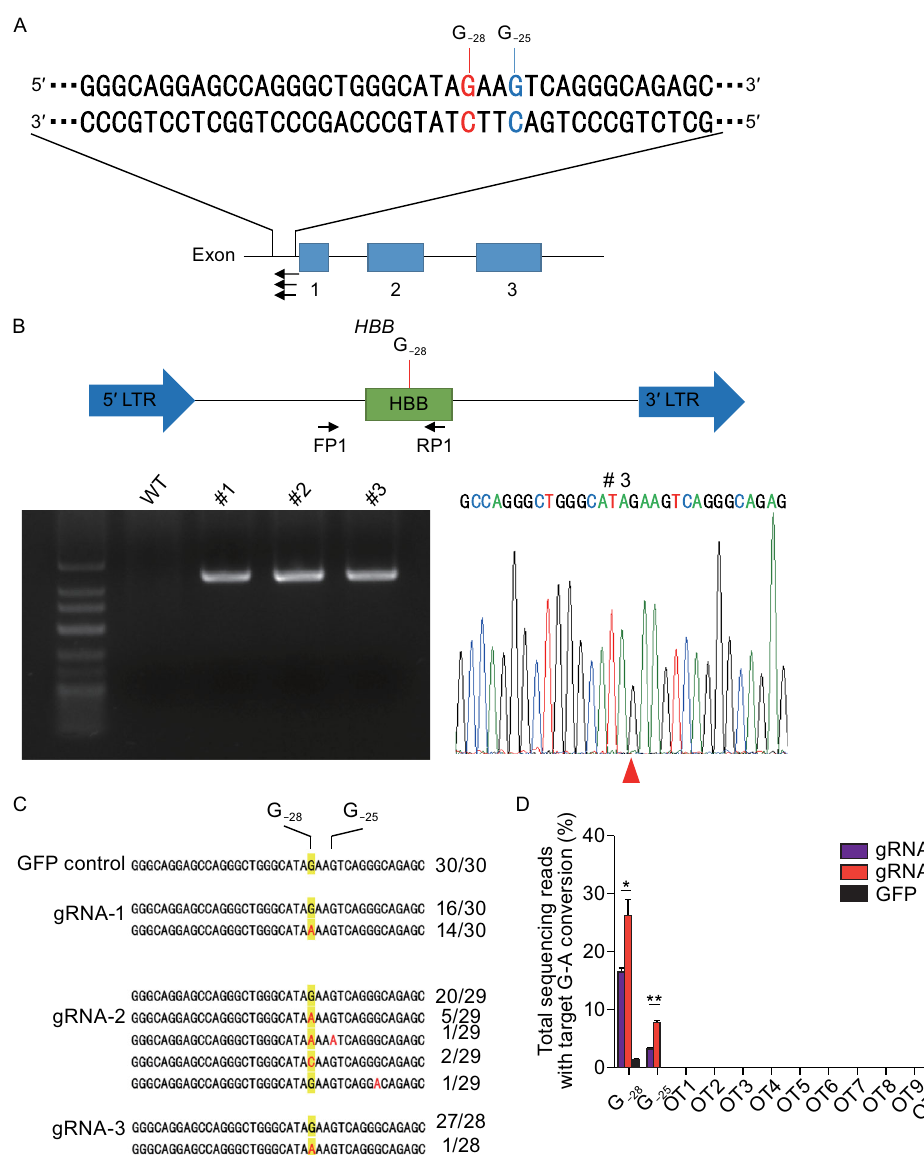
Figure 1. Correcting HBB − 28 (A>G) mutation in human cell line. (A) Schematic of HBB − 28 (A>G) mutation. The exons are labeled with blue boxes. − 28 (A>G) mutation was in red and indicated with red line (G − 28 ). The − 25 (G), next to G − 28 , was in blue and indicated with blue line (G − 25 ). And gRNAs were labeled with black arrow. (B) Generation of HBB − 28 (A>G) mutant stable cell lines. A fragment of HBB gene, containing the − 28 (A>G) mutation, was cloned into a lentiviral vector. Packaged lentivirus was used to infect 293T. Virus-infected cells were selected by puromycin. 7 days after selection, single clones of cells were picked. The up panel showed the design of the recombined lentivirus vector. HBB gene fragment containing − 28 (A>G) mutation was labeled with green box. LTR (long terminal repeat) region of lentiviral vector was labeled with blue arrowhead. PCR primer used to speci fi cally amplify HBB fragment from integrated provirus were showed. The down panel showed the results of one wild-type 293T cells and three clones, ampli fi ed using FP1 and RP1. Representative sequencing chromatographs of the PCR amplicons of #3 clone were shown. The mutant base (G − 28 ) was indicated by red arrowheads. (C) Precise repairing of HBB − 28 (A>G) mutation by base editor 3 in the HBB − 28 (A>G) mutant stable cell line. TA cloning sequencing showed clear G>A conversion at the target site. The frequency of each allele is shown. (D) Deep sequencing to detect on-target and off-target deamination at 10 potential off-target sites in HBB − 28 (A>G) mutant stable cell line. Bars represent mean ± SEM ( n = 3). Signi fi cance was calculated using a two-tailed unpaired t test (* P < 0.05, ** P <